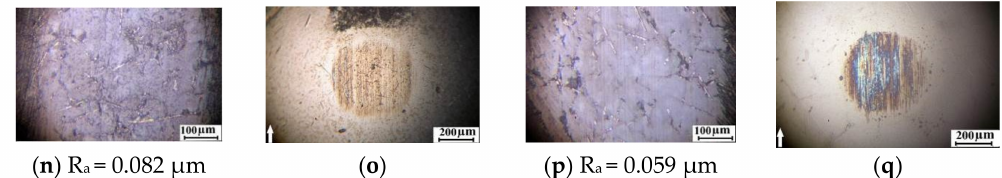
Figure 5. Optical images of the wear track surfaces and the counterparts at the steady state wearing stage: ( a – d ) PEEK; ( d – q ) the PEEK-based composites (( e–h )–PEEK + 10% PTFE; ( i–m )–PEEK + 10% CF; ( n–q )–PEEK + 10% PTFE + 10%